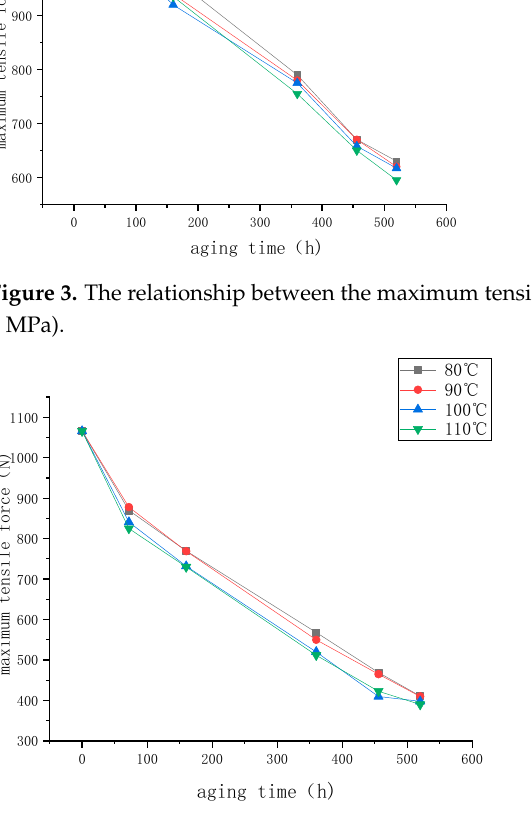
Figure 4. The relationship between the maximum tensile force of the pipe and the aging time (PE80, 0.6 MPa).